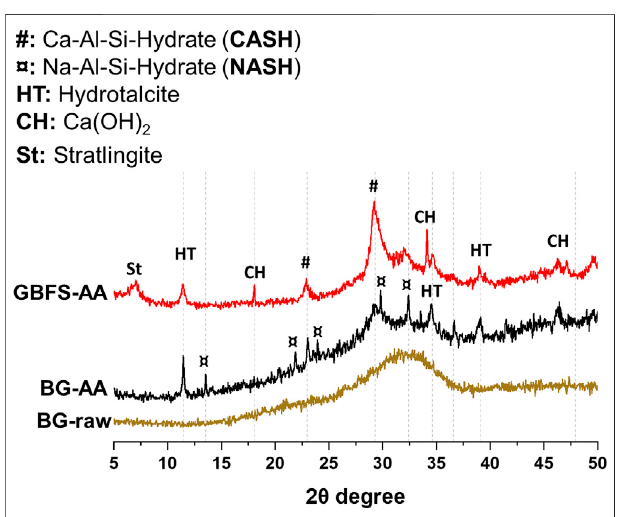
FIGURE 3 | XRD patterns for the raw BG and the alkali activated